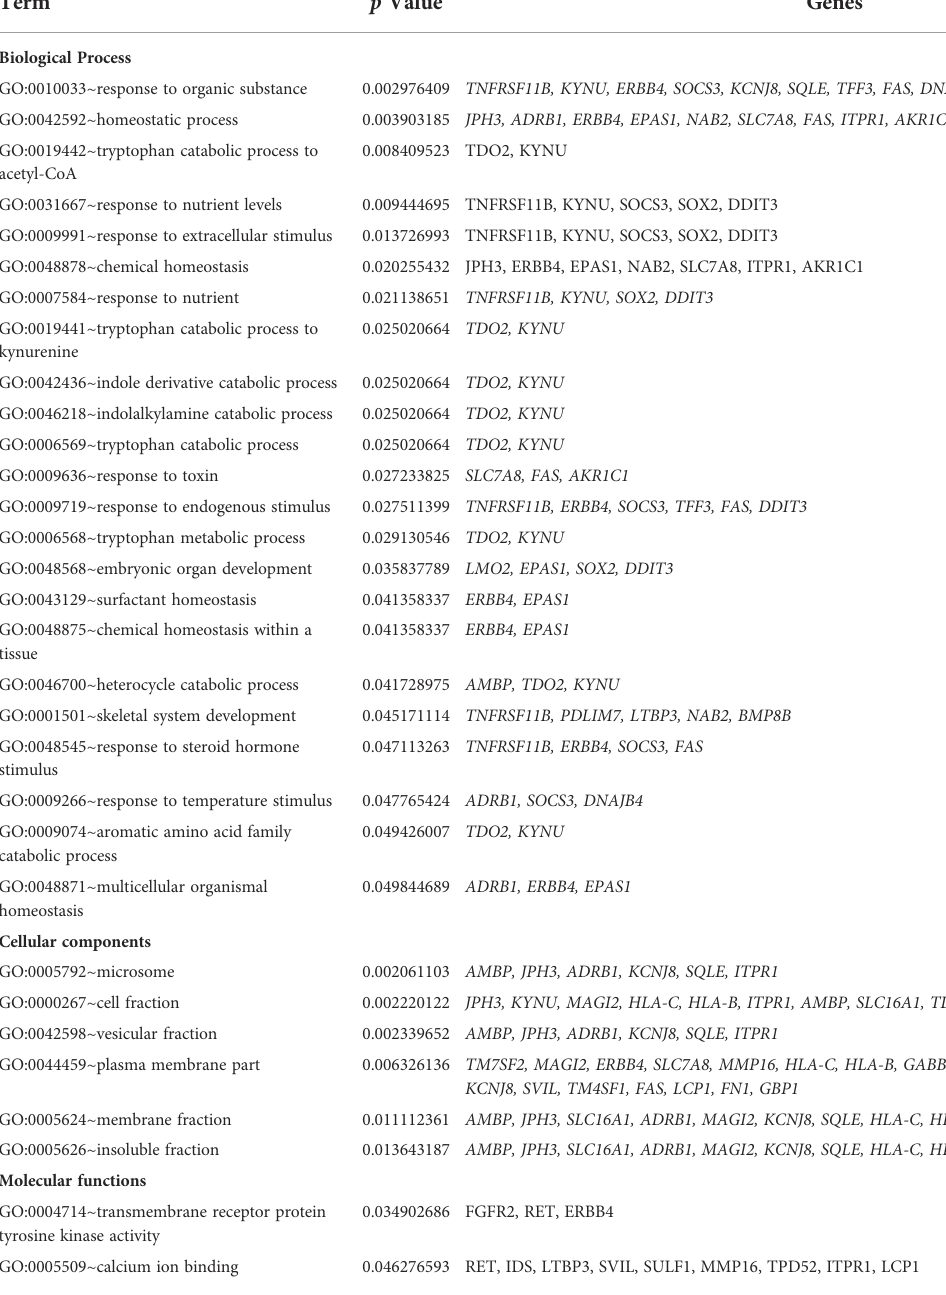
TABLE 1 GO enrichment analysis of the overlapping